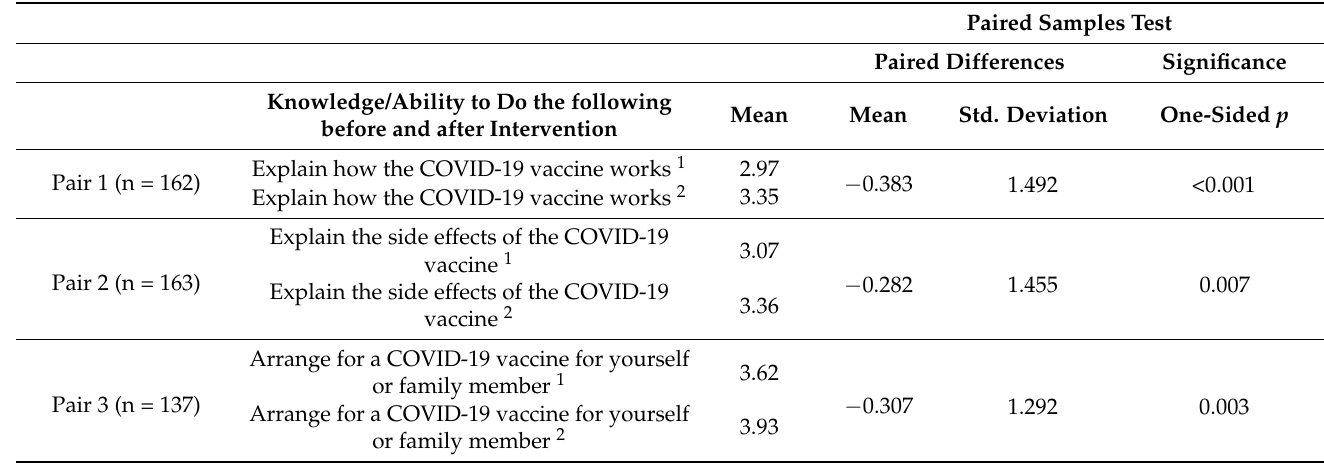
Table 4. Change in knowledge regarding COVID-19 vaccines between baseline and follow-up.